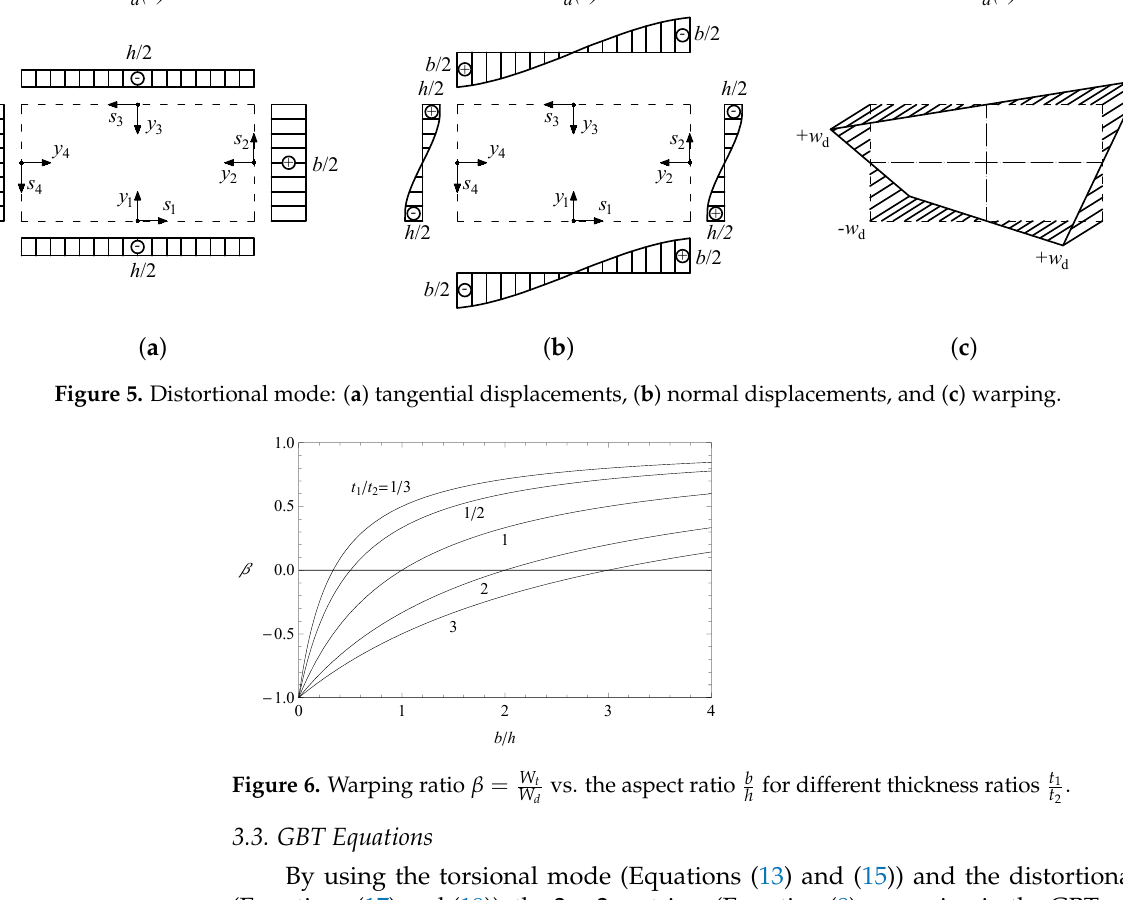
vs. the aspect ratio b W d